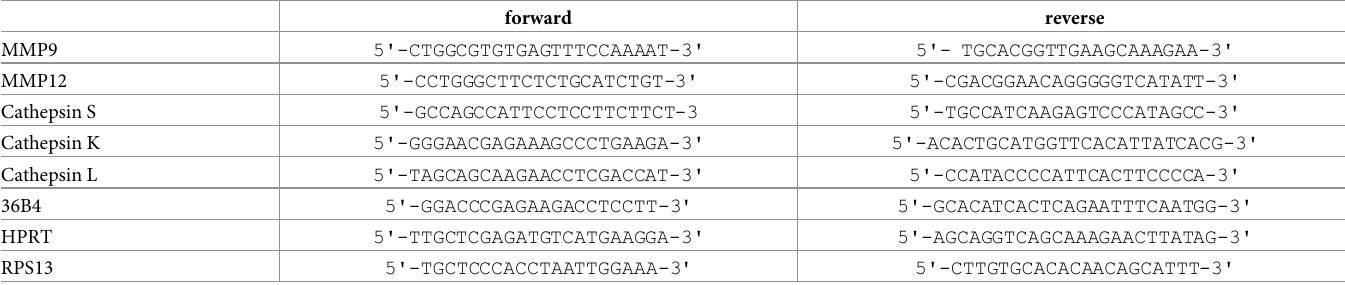
Table 1. Primer pairs used for quantitative gene expression